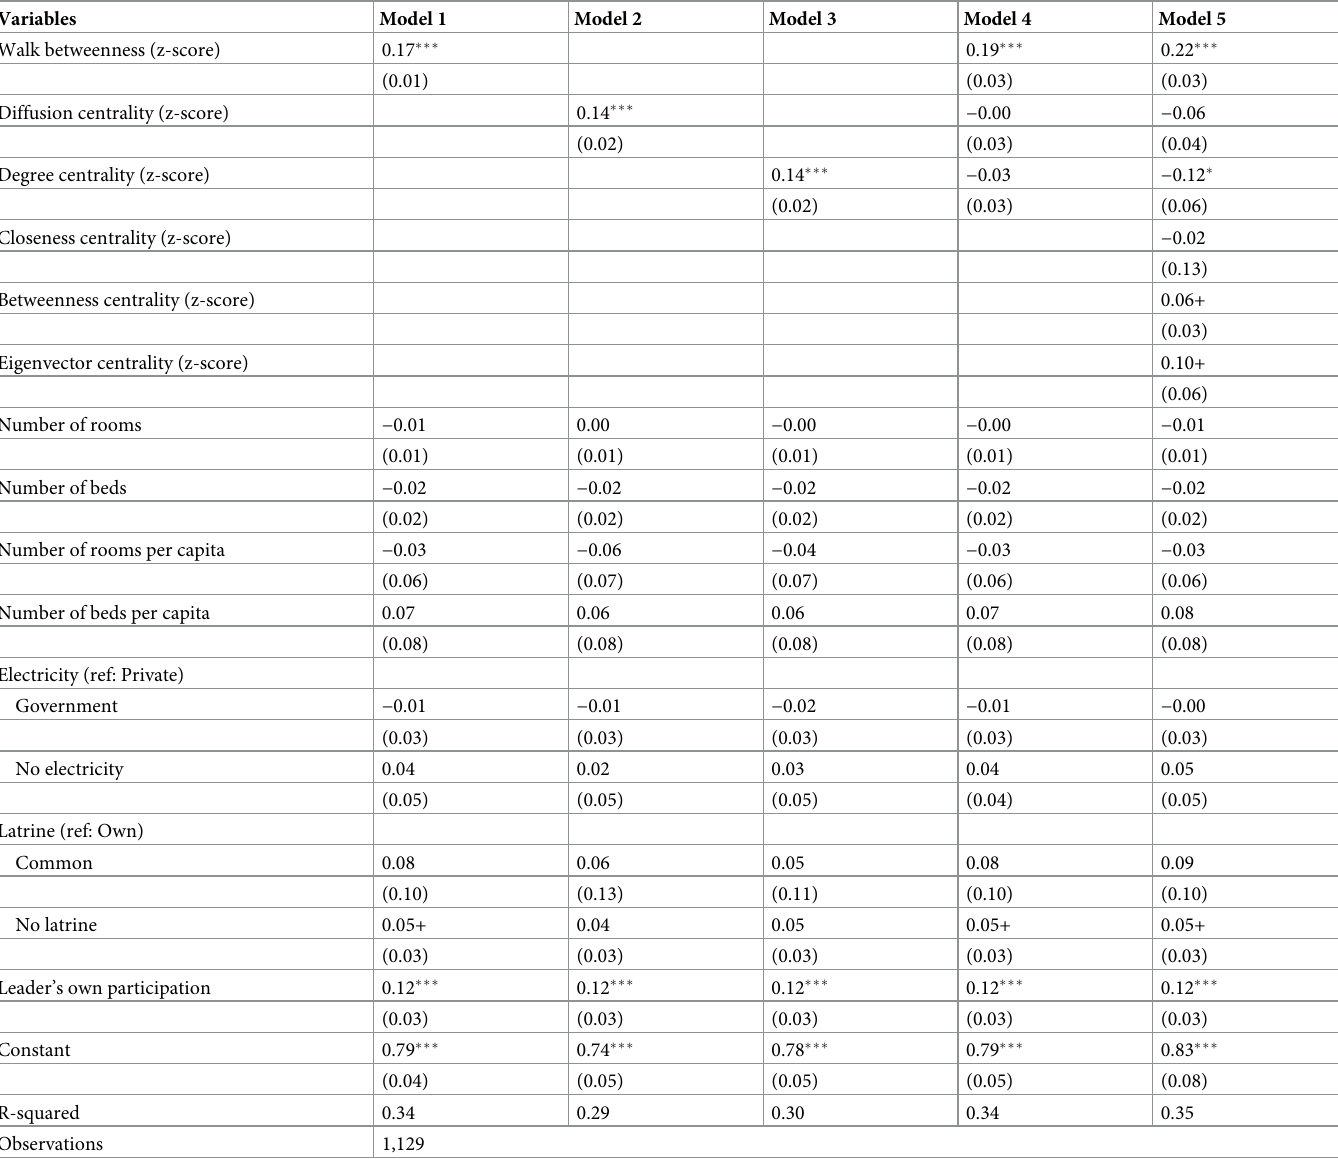
Table 5. Village-fixed effects regression models for the followers’ microfinance take-up rate among leader households in the 75 Indiana